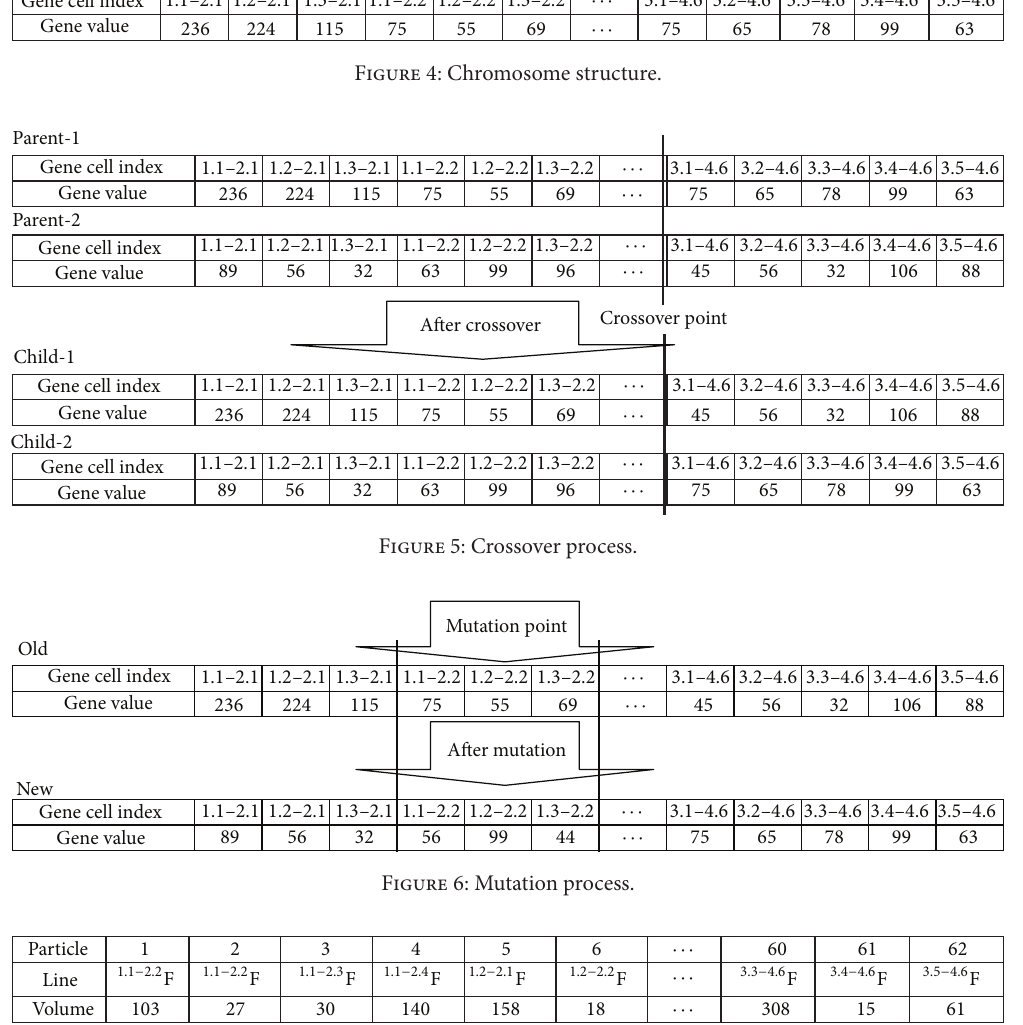
Figure 7: Particle swarm encoding for forward logistics.